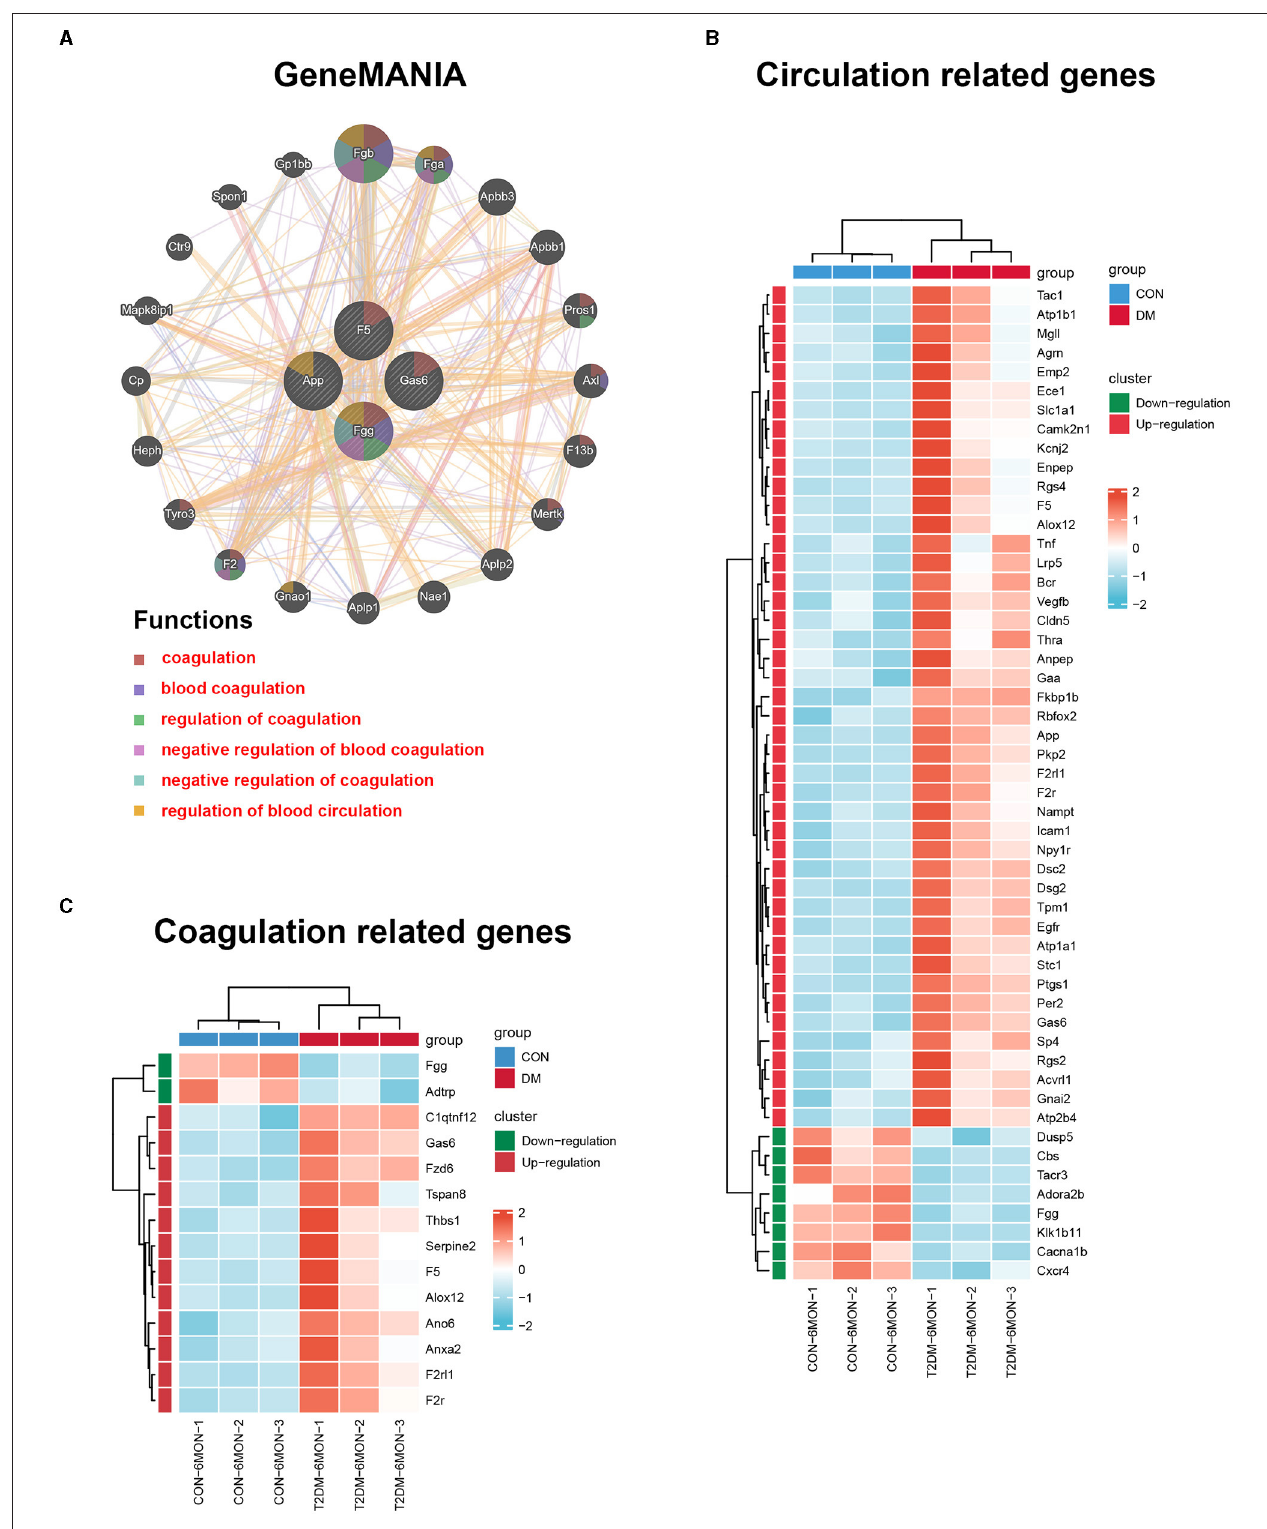
FIGURE 8 | GeneMANIA analysis and the expression heatmaps of the functionally related genes. (A) GeneMANIA analysis was performed to find genes with shared properties and similar functions to the four hub genes above and the interactive functional association network. Interactive functional association networks showed a connection with the regulation of coagulation and circulation. (B) The differential expression of circulation-related genes in T2DM and control groups. (C) The differential expression of coagulation-related genes in T2DM and control groups. The data were transferred to the Z-score of FPKM by each row and clustered based on the Euclidean distance ( n =